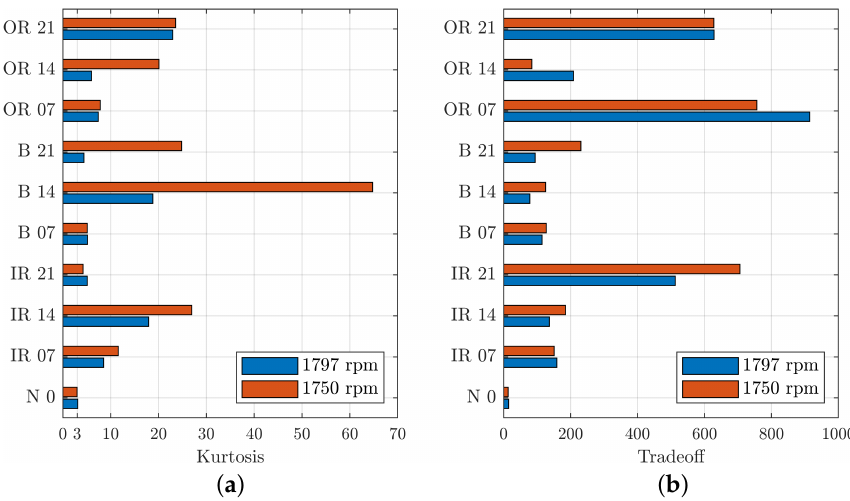
Figure 14. Comparison of kurtosis ( a ) and TO ( b ) between different shaft speeds for different defect locations and diameters. On the y -scale, the letters indicate the position of the defect and the numbers indicate the defect diameter size in thousandths of an